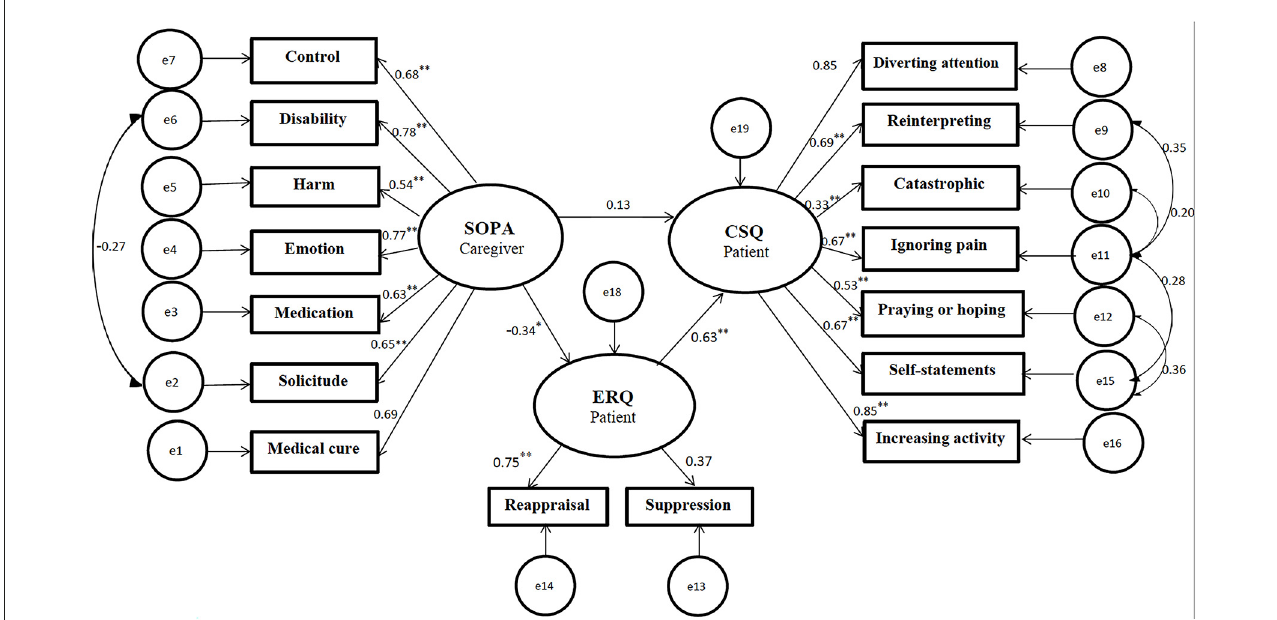
FIGURE2 Predicted relationship based on Model 1 (with resulting standardized regression weights). All coefficients are significant ( p < 0.05 ∗ p < 0.001 ∗∗ ). SOPA, survey of pain attitudes; CSQ, coping strategies questionnaire; ERQ, emotion regulation